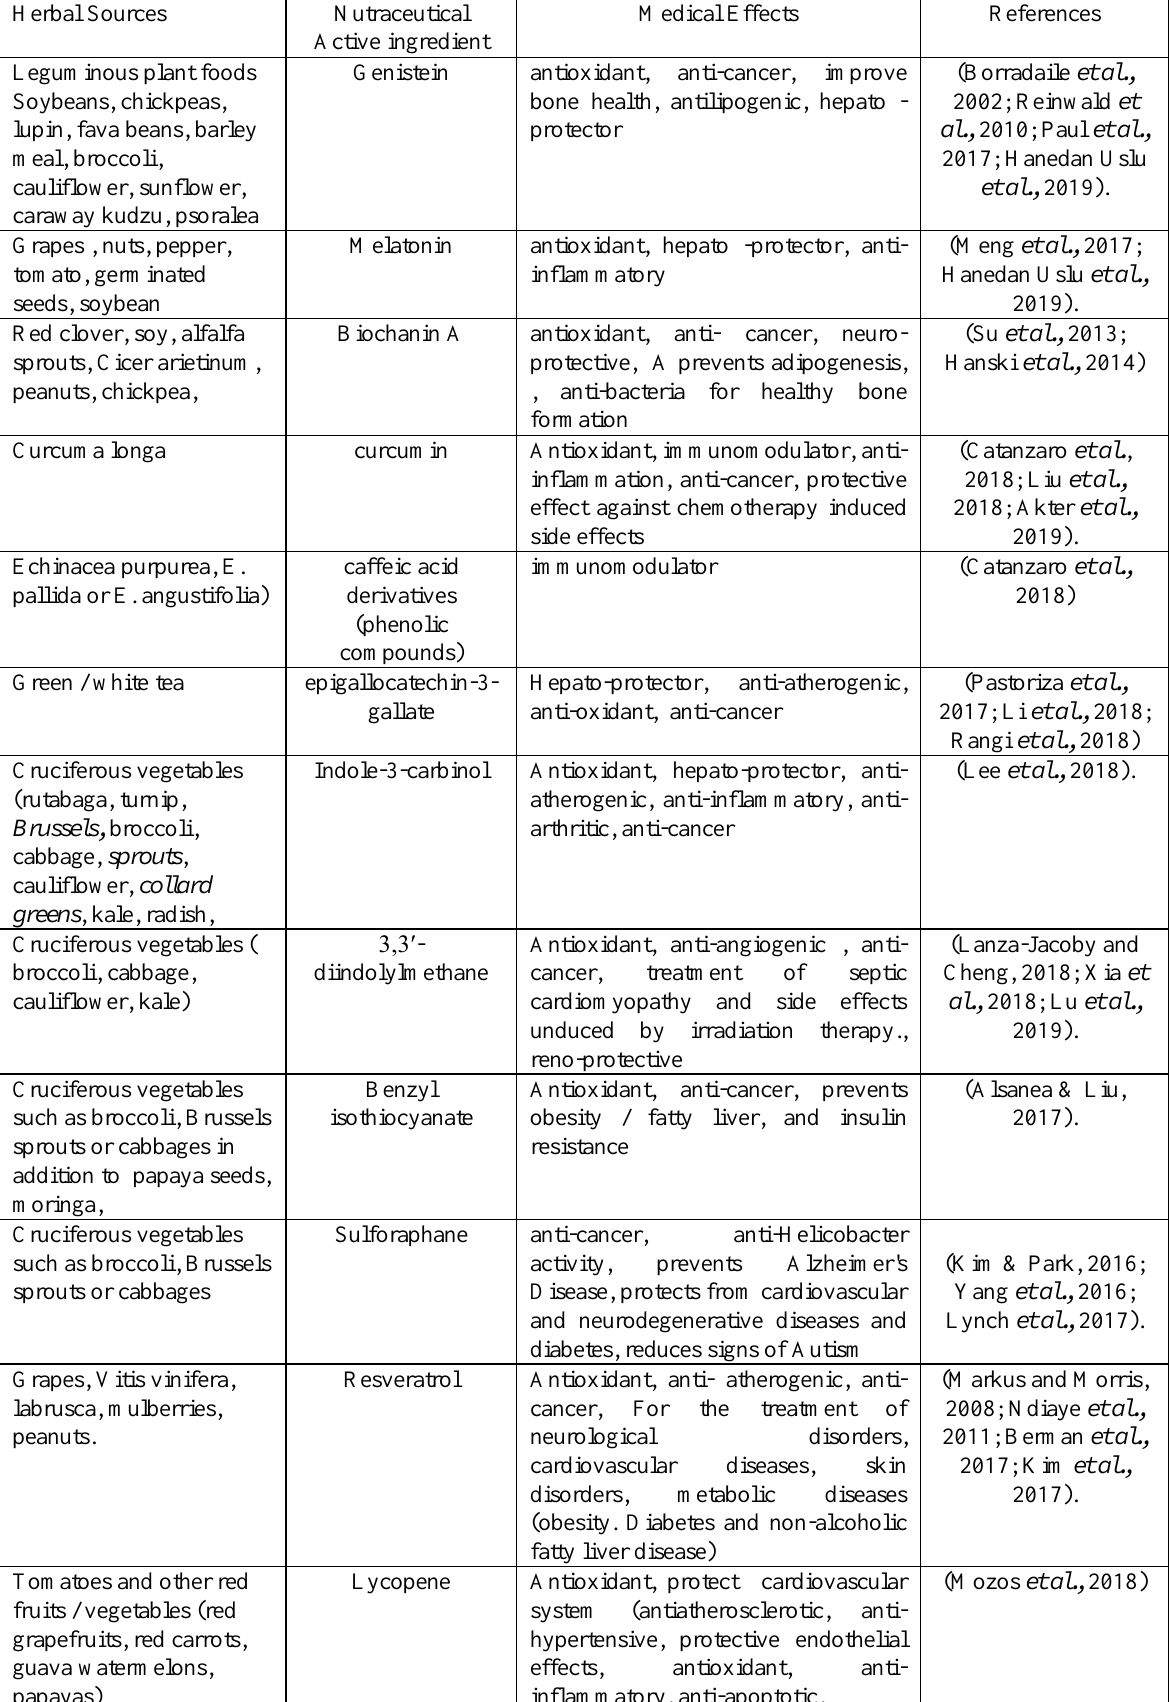
Table 1: Examples for investigated nutraceutics which exert their action via epigenetic modulations: Herbal